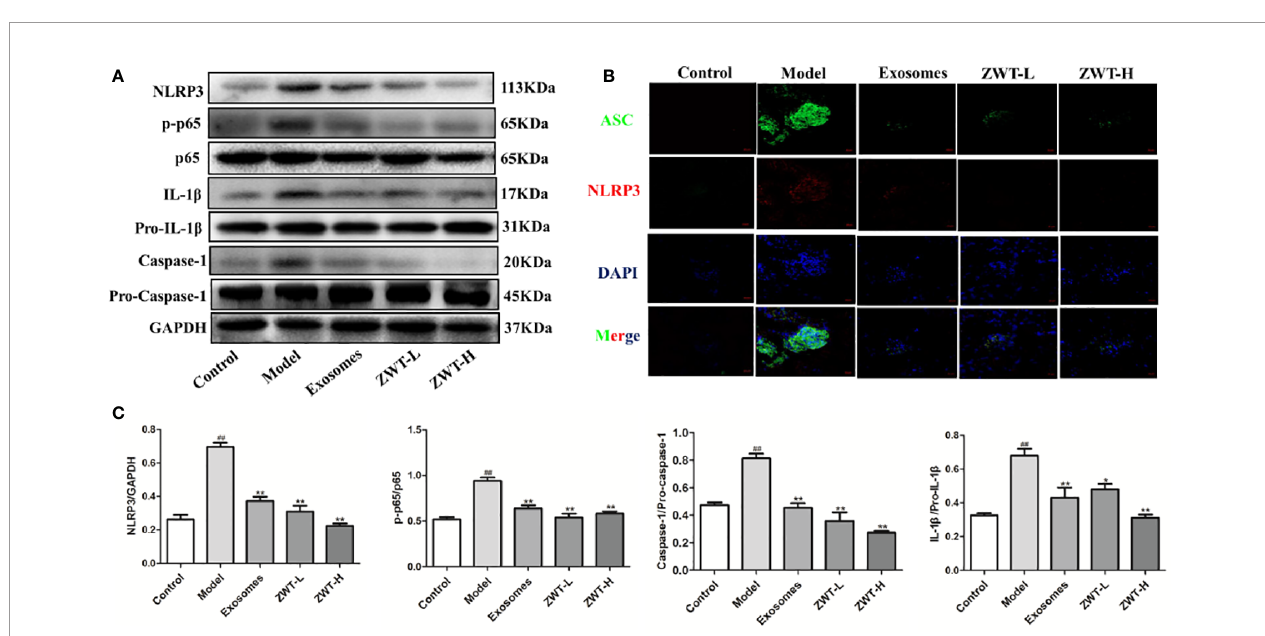
FIGURE 9 | ZWT blocked the NF- k B/NLRP3 signaling pathway in immunoglobulin A nephropathy (IgAN) model rats. (A, C) Western blot was carried out to investigate the expressions of NLRP3, p-p65, p65, caspase-1, pro – caspase-1, IL-1 b , and pro – IL-1 b in the kidney tissues of IgAN rats. The statistical data of all the proteins were analyzed and transformed by ImageJ 1.8.0 112 software. The obtained values of p-p65 were normalized to p65, caspase-1 were normalized to pro – caspase-1 and IL-1 b were normalized to pro – IL-1 b . (n= 3). Data were shown as mean ± SD. # P < 0.05, ## P < 0.01, compared with control group; *P < 0.05, **P < 0.01, compared with lipopolysaccharide (LPS) group. (B) The colocalization images of NLRP3 and ASC were measured by immuno fl uorescence with confocal imaging at ×400magni fi cation. Scale bar: 20 m